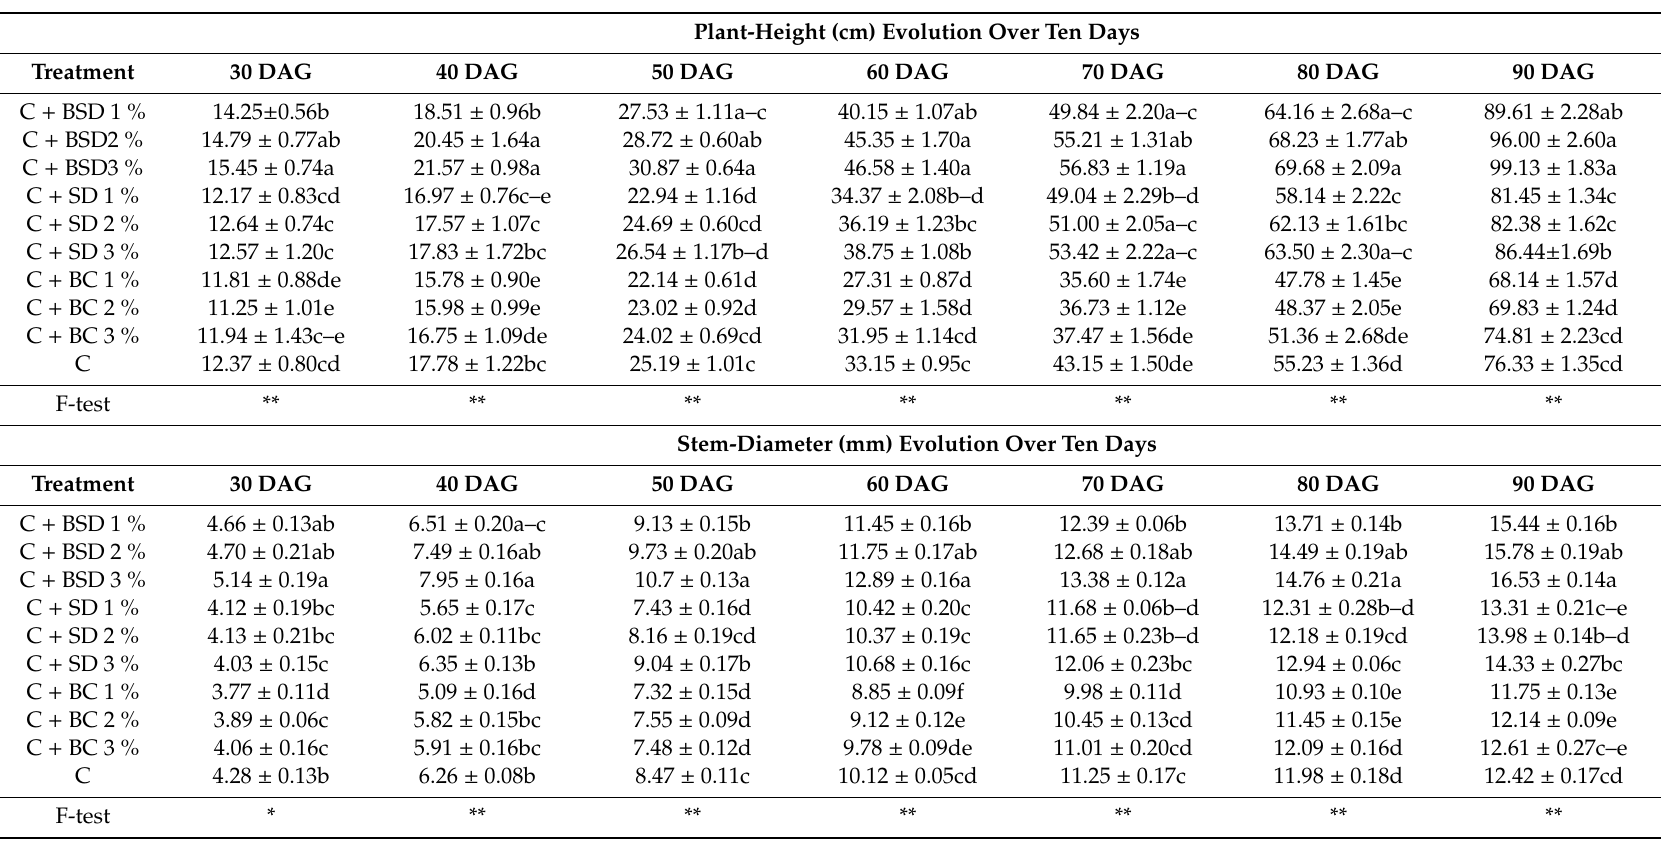
Table 4. E ff ects of soil amendments on growth parameters in maize cultivation ± standard error. Plant-Height (cm) Evolution Over Ten